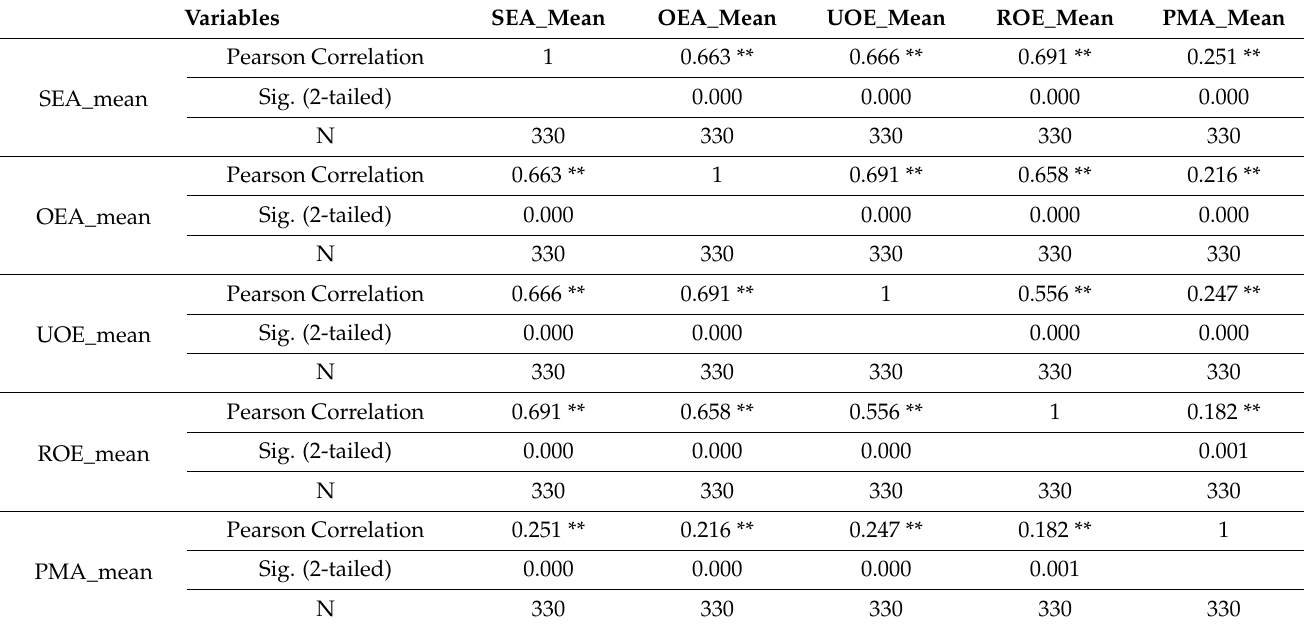
Table 3. Pearson Correlation Matrix.